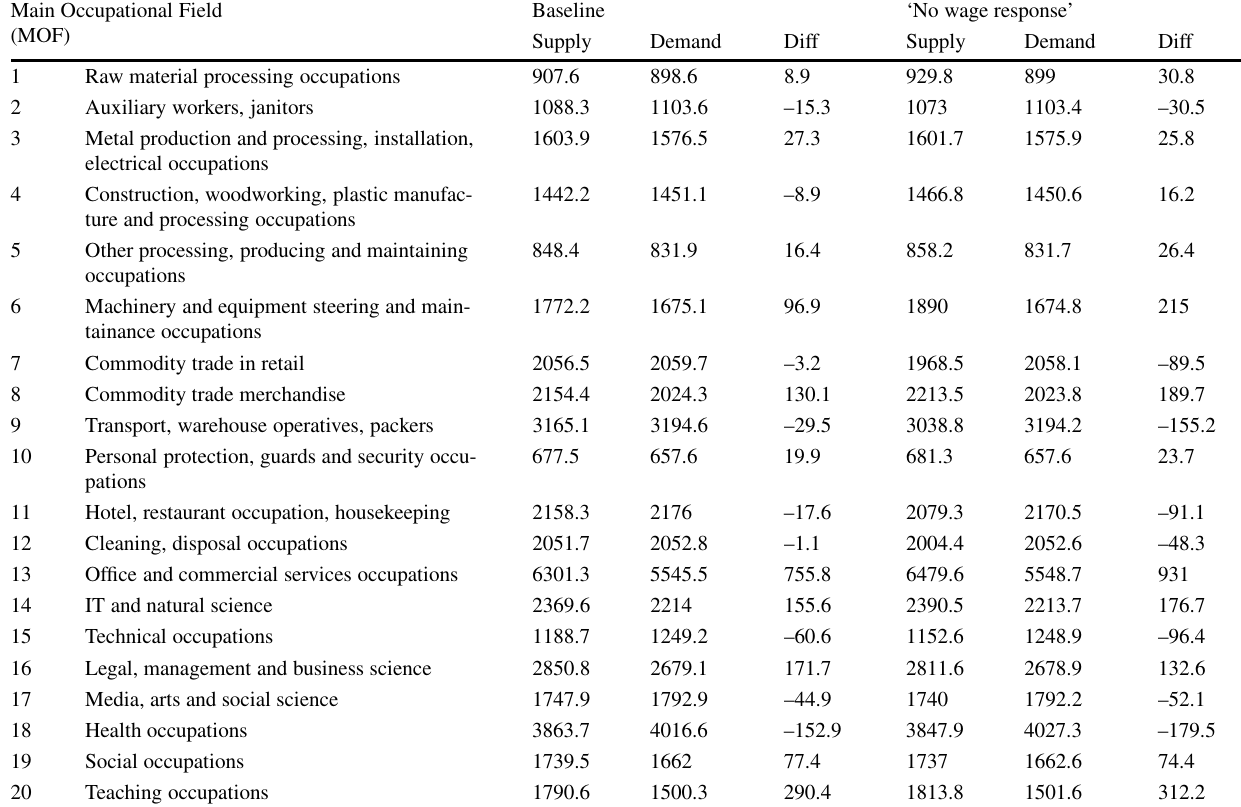
Table 3 Labour demand and supply in 1000 persons by 20 MOF in 2030 in the baseline and ‘no wage response’ scenario Main Occupational Field